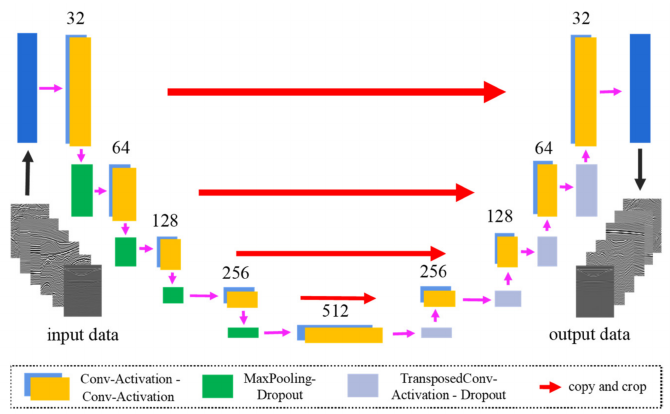
Figure 1. Sketch of a deep U-net